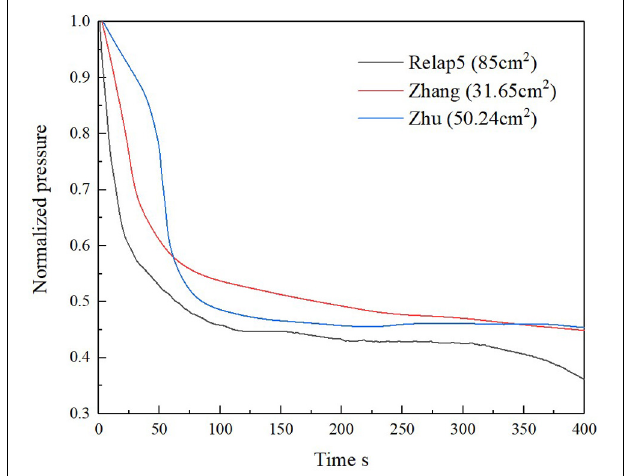
FIGURE 4 | PRZ pressure in small-break loss-of-coolant accident